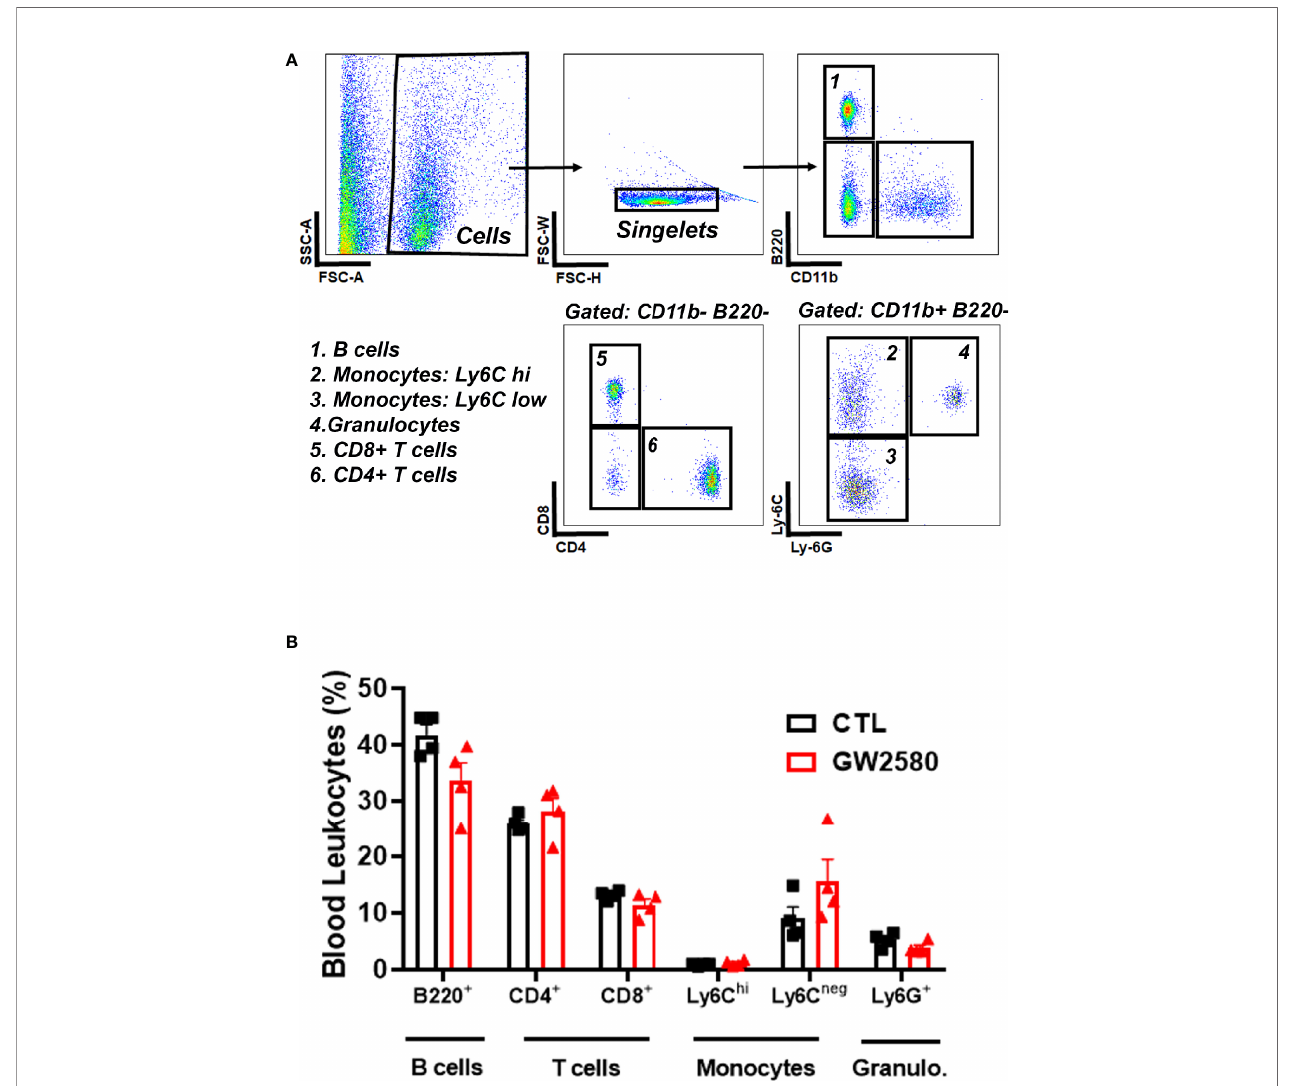
FIGURE 2 | Effect of GW2580 treatment on blood leukocytes. (A, B) Mice were treated with vehicle or GW2580 by oral gavage for 8 days and the effect of treatment on circulating leukocytes determined by fl ow cytometry. (A) Representative gating strategy used to determine the percentage of B cell, T cell, monocyte and granulocyte subsets. (B) Cell percentages of blood leukocytes from vehicle and treated mice are shown. Data are expressed as means ± standard error (S.E.), n=4 per